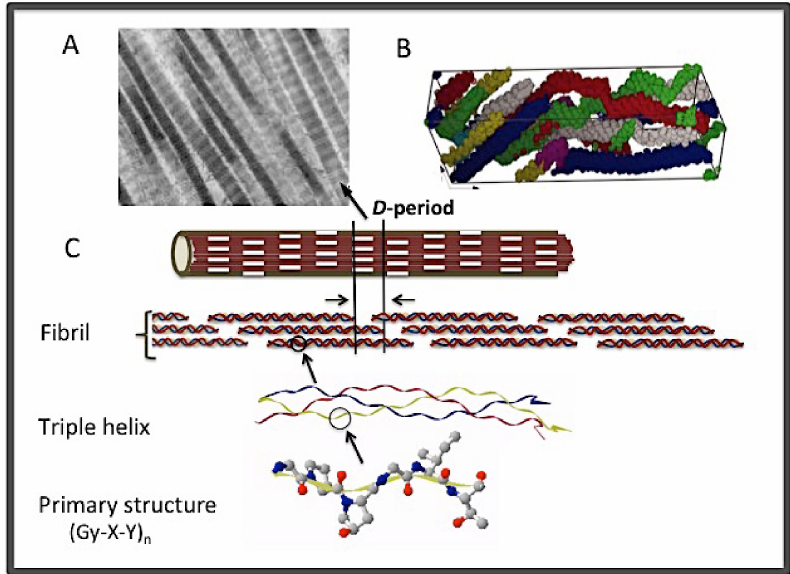
Figure 2. The structural hierarchy of fibrillar collagen. ( A ) Electron micrograph of collagen fibrils showing the characteristic striation pattern of the D -period and the tipped ends. ( B ) The unit cell of collagen fibril showing the staggered and intertwined arrangement of five triple helices (in different colors) due to the super-twist of the triple helices in fibrils [33]. ( C ) The different stages of fibrillogenesis from the primary structure to